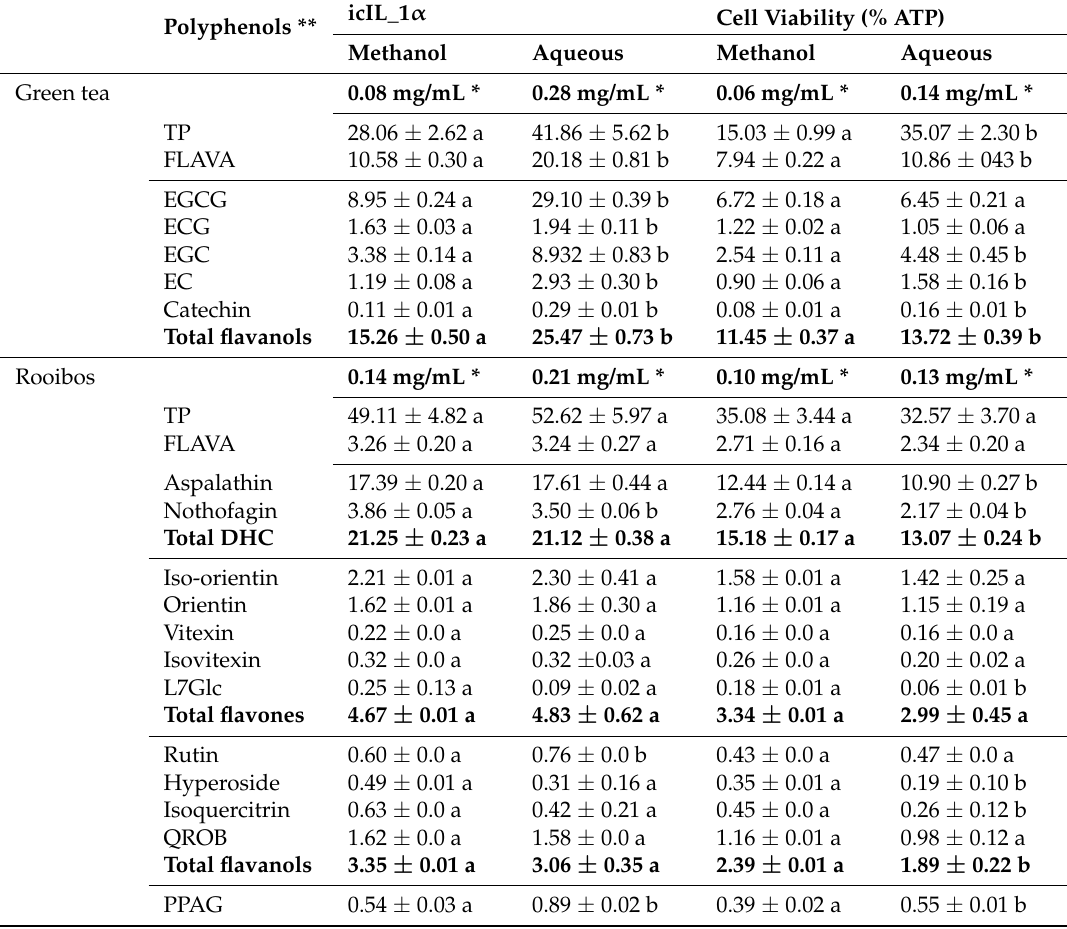
Table 6. Polyphenol concentration ( µ g/mL) of green tea and rooibos extracts expressed as a function of the IC 50 values for the inhibition of icIL-1 α accumulation and reduction of cell viability following UVB irradiation in HaCaT